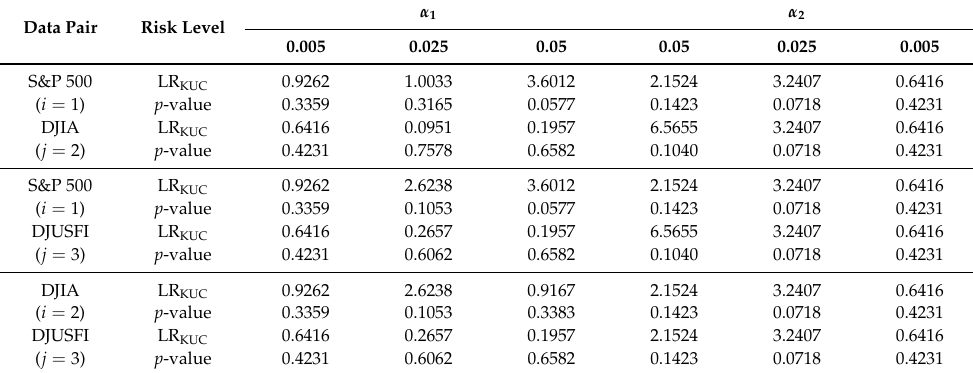
Table 7. Forecast performance measures of the test statistic and p -value of KUC test for one-day- ahead VaR return forecasts at the lower and upper risk levels 0.005, 0.025 and 0.05 using the best two-stage MCARR-return model with volatility forecasts from MCARR(1,1,0) 12 , MCARR(1,1,1) 13 and MCARR(1,1,0) 23 models for the S&P 500, DJIA and DJUSFI indices. The subscripts ij in MCARR(1,1,0) ij and MCARR(1,1,1) ij for some i < j and i , j = 1,2,3 refer to i and j data pair. Data Pair